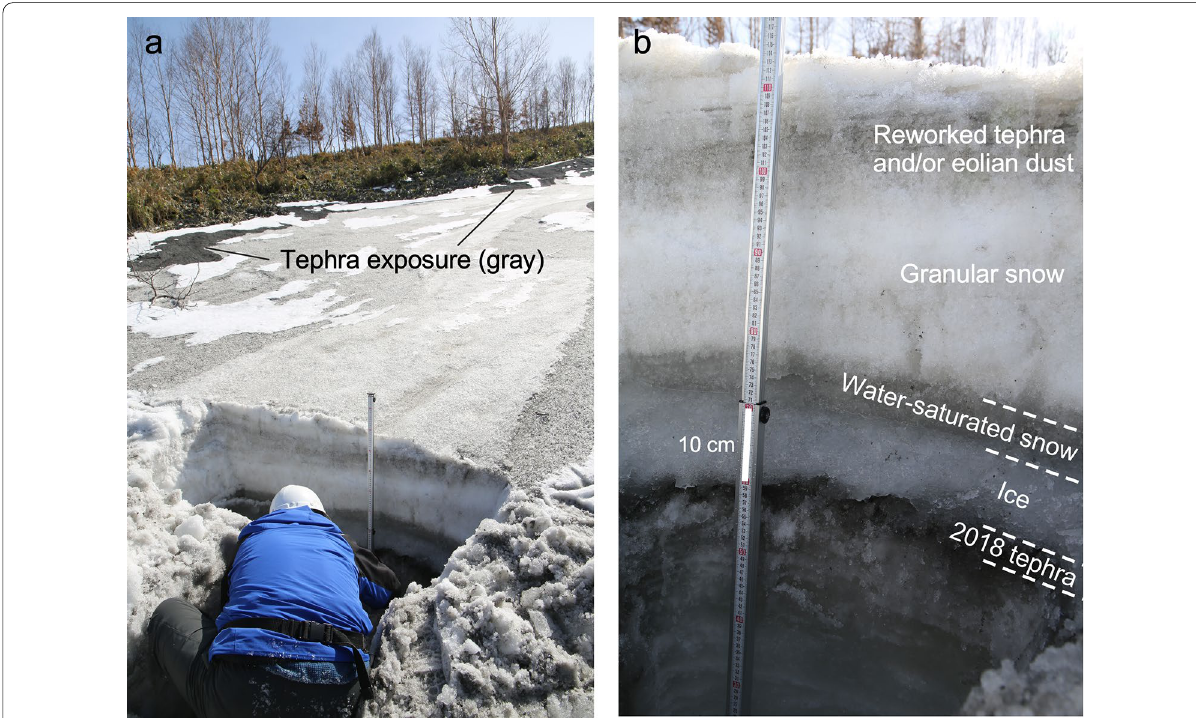
Fig. 9 Snowpack with intercalation of the 2018 tephra fall deposits on the northern and proximal slope nearby Motoshirane (1838 m a.s.l.) on April 10, 2018 in the snowmelt season. a A 2.75 m depth snowpack with patchy tephra exposure on the snow surface, and b A-10-cm thick ice layer developing above the 2018 eruption deposits (dark gray, 2 cm thick), overlain by water-saturated snow layer. Partly dark-colored part below the ashfall deposits is due to the wet snow (not ash infiltration); it became darker when water flowed from the above layer during digging the